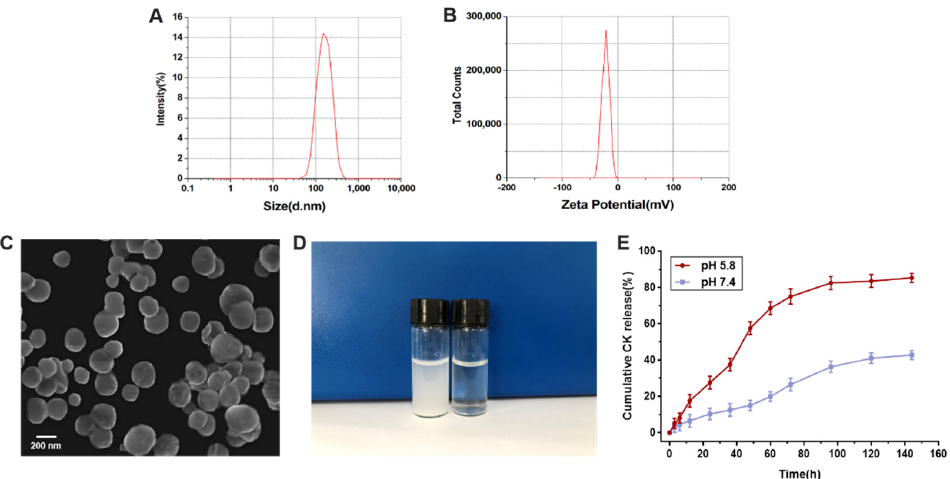
Figure 4. Characterization and drug release of CK-Ngs. ( A ) Size distribution and ( B ) zeta potential distribution determined through DLS and analyzed using Zetasizer. ( C ) Scanning electron microscope (SEM) of CK-Ngs. ( D ) CK and CK-Ngs in water at the same concentration. ( E ) In vitro release profile of ginsenoside CK in CK-Ngs under different pH environments.